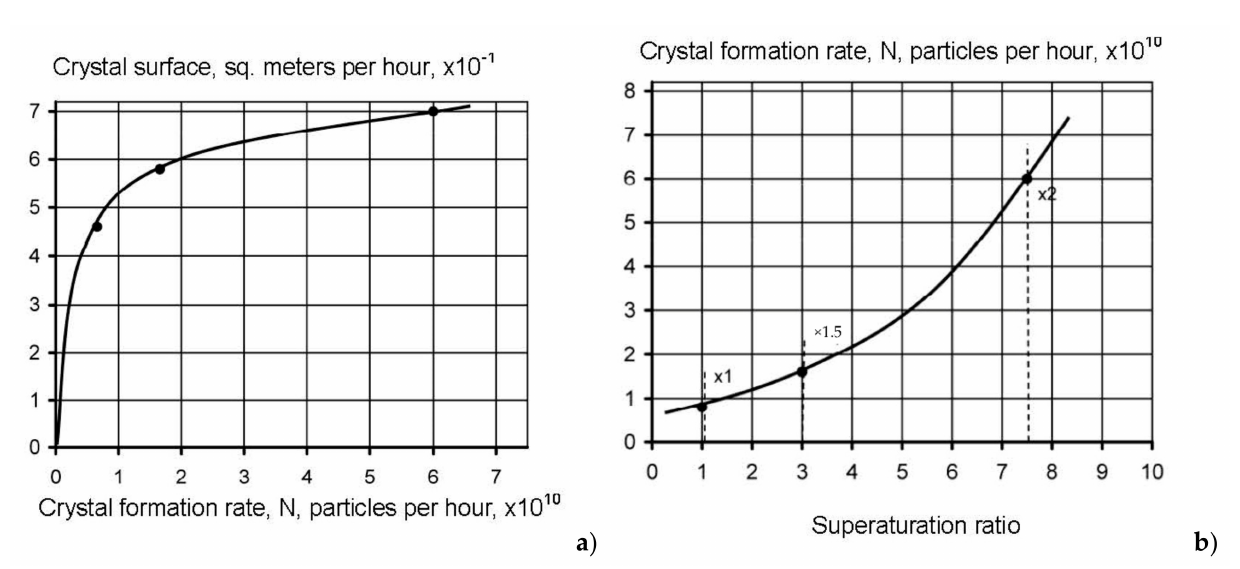
Figure 12. Dependencies of crystal surface area on nucleation rate N ( a ) and nucleation rate N on supersaturation ( b ) for the case of Aminat-K application: 1—Aminat-K dose—2 ppm, K f = 1.2;